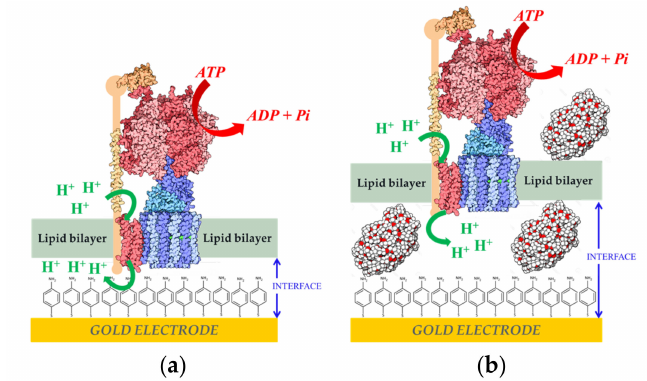
Figure 5. Adenosin triphosphate-synthase from Escherichia coli (ATPase) reconstitution in ( a ) fBLM ( b ) fBLM-polyethylene glycol (fBLM-PEG) over gold electrodes modified with a 4-APh self-assembled monolayer (SAM). Reprinted from [77] with permission from